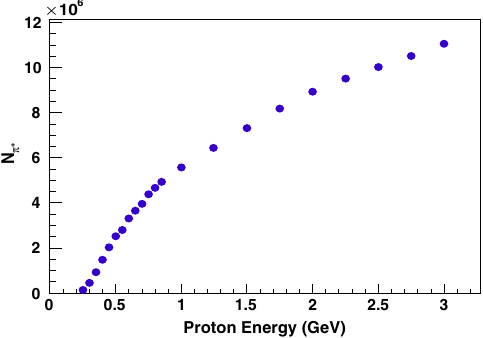
FIG. 5. Proton transmission through the muon target as a function of the proton beam energy.